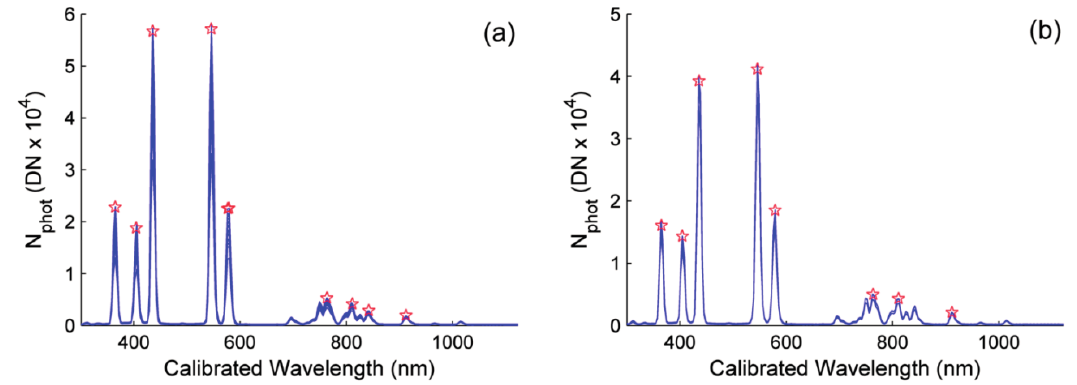
Figure 4. Hg-Ar lamp emission lines spectra. The bands selected for the spectral calibration of each channel are marked with a star. ( a ) Channel 1; ( b ) Channel